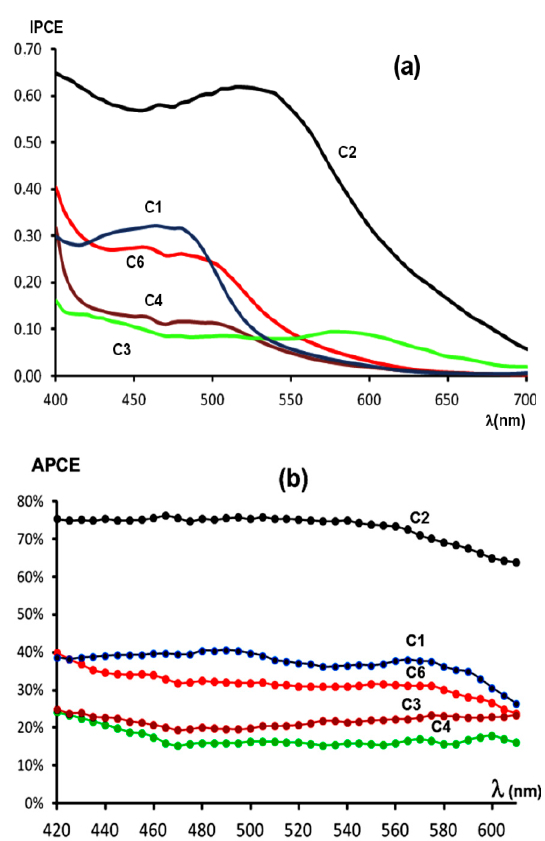
Figure 22. ( a ) IPCE ( b ) APCE for the series of complexes under Figure 22 . ( a ) IPCE ( b ) APCE for the series of complexes under study.